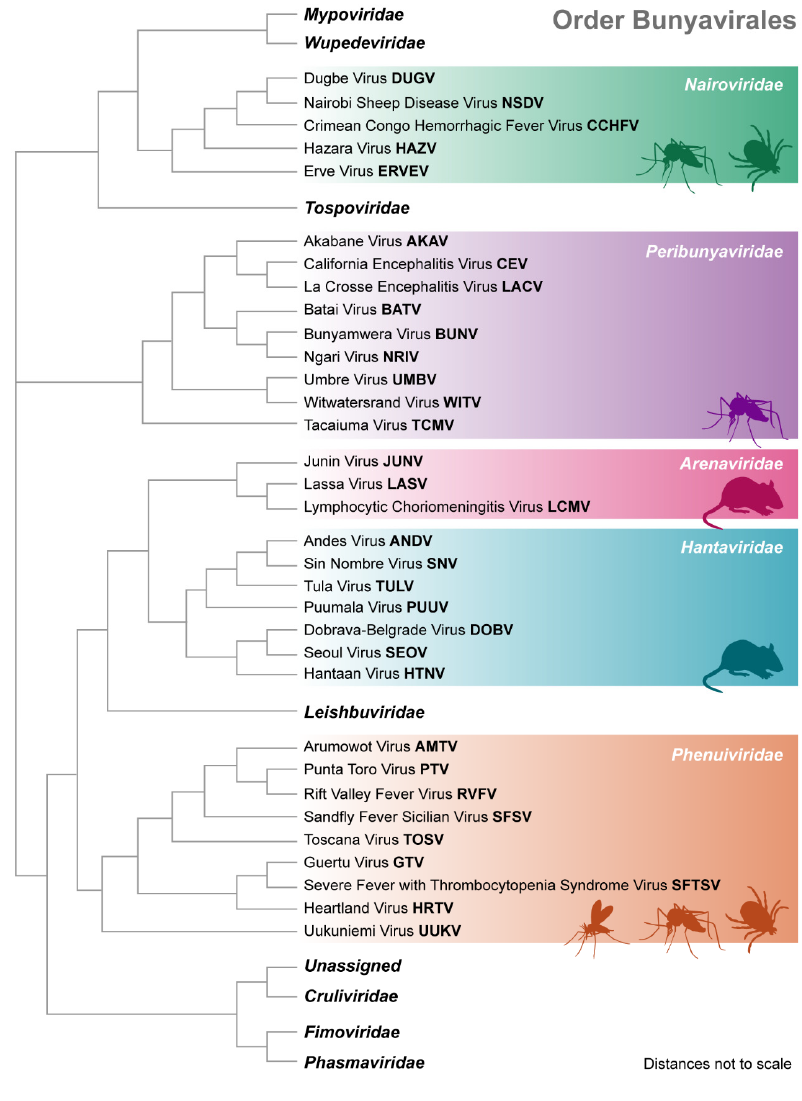
Figure 1. Bunyavirales Phylogenetic Tree. Order Bunyavirales phylogenetic tree based on nucleoprotein amino acid sequences of the 13 families. Families for which a specific virus is not listed are arranged via analysis of type species as listed in Table 1. Specific vector species are depicted for Nairoviridae (mosquito, tick), Peribunyaviridae (mosquito), Arenaviridae (rodent), Hantaviridae (rodent), and Phenuiviridae (sandfly, mosquito, tick). While these families may contain viruses trans- mitted through other vectors, these illustrations represent those of the viruses listed and discussed in this review. The phylogenetic tree was constructed using S segment nucleoprotein amino acid sequences from Genbank and was assem- bled using Geneious Prime tree builder global alignment with free end gaps, cost matrix PAM250, genetic distance model Jukes-Cantor, tree build method neighbor-joining, and no outgroup. The resulting tree was transformed so that branches are of equal length. Tree segments are not to scale. Genbank accession numbers for sequences used: Mypoviridae